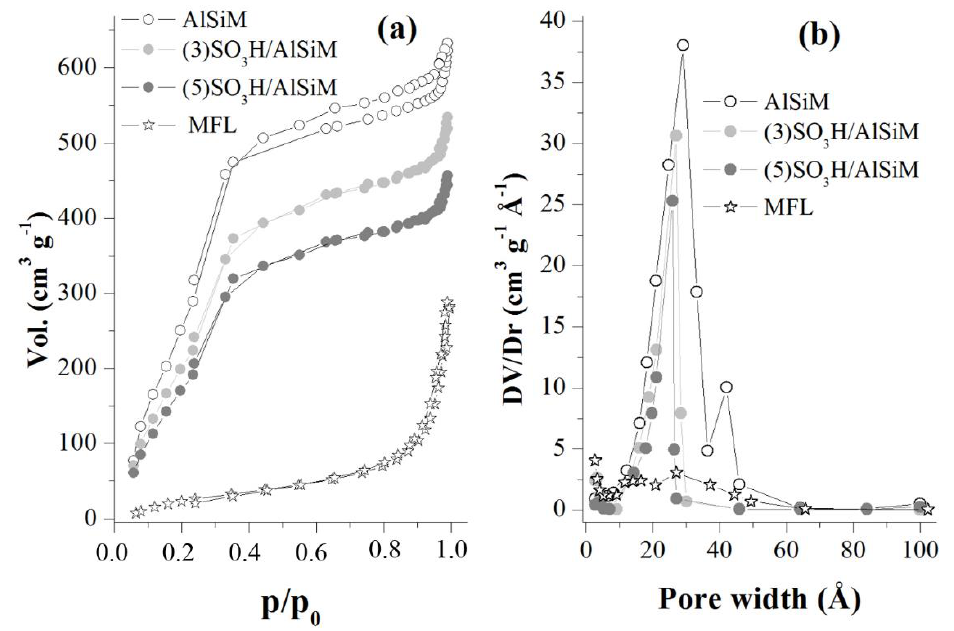
Figure 2. N 2 physisorption isotherms ( a ) and pore size distribution curves ( b ) of MFL, AlSiM and (3 or 5)SO 3 H/AlSiM.